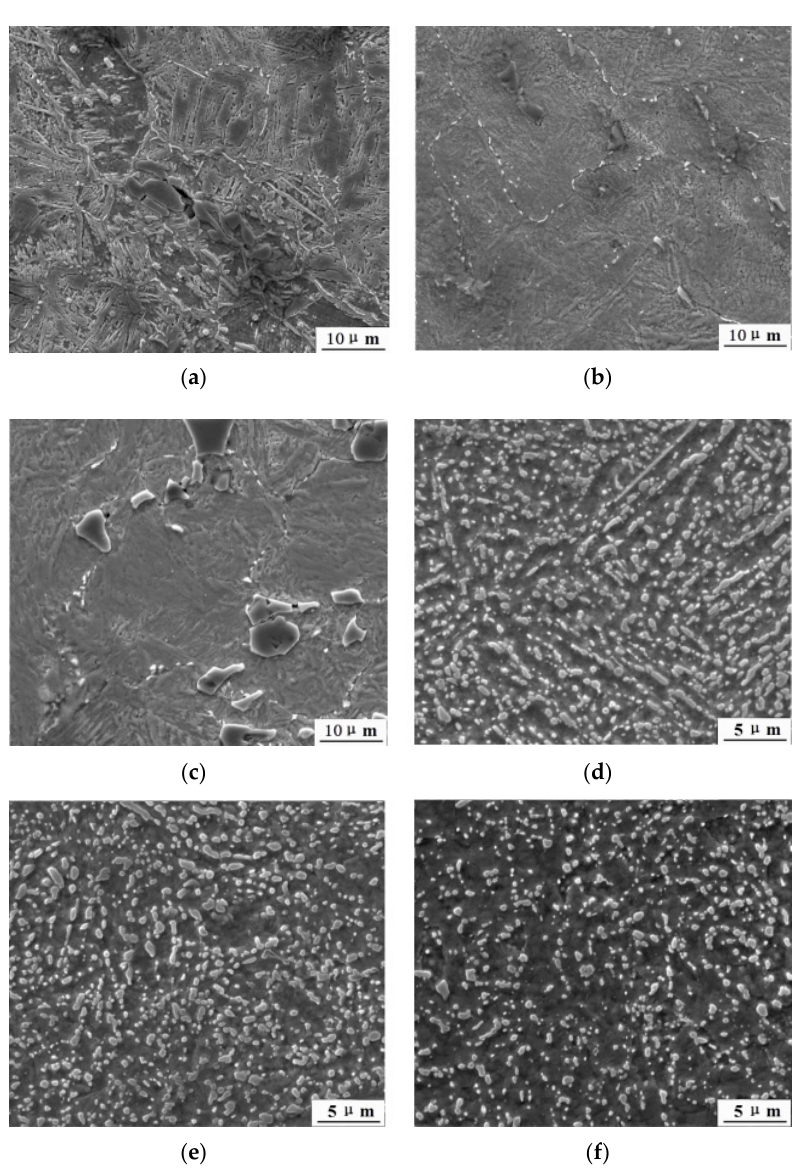
Figure 3. SEM images of specimens before and after spheroidizing annealing: ( a – c ) samples No. 1, No. 2, No. 3 before spheroidizing annealing; ( d – f ) samples No. 1, No. 2, No. 3 after spheroidizing annealing.